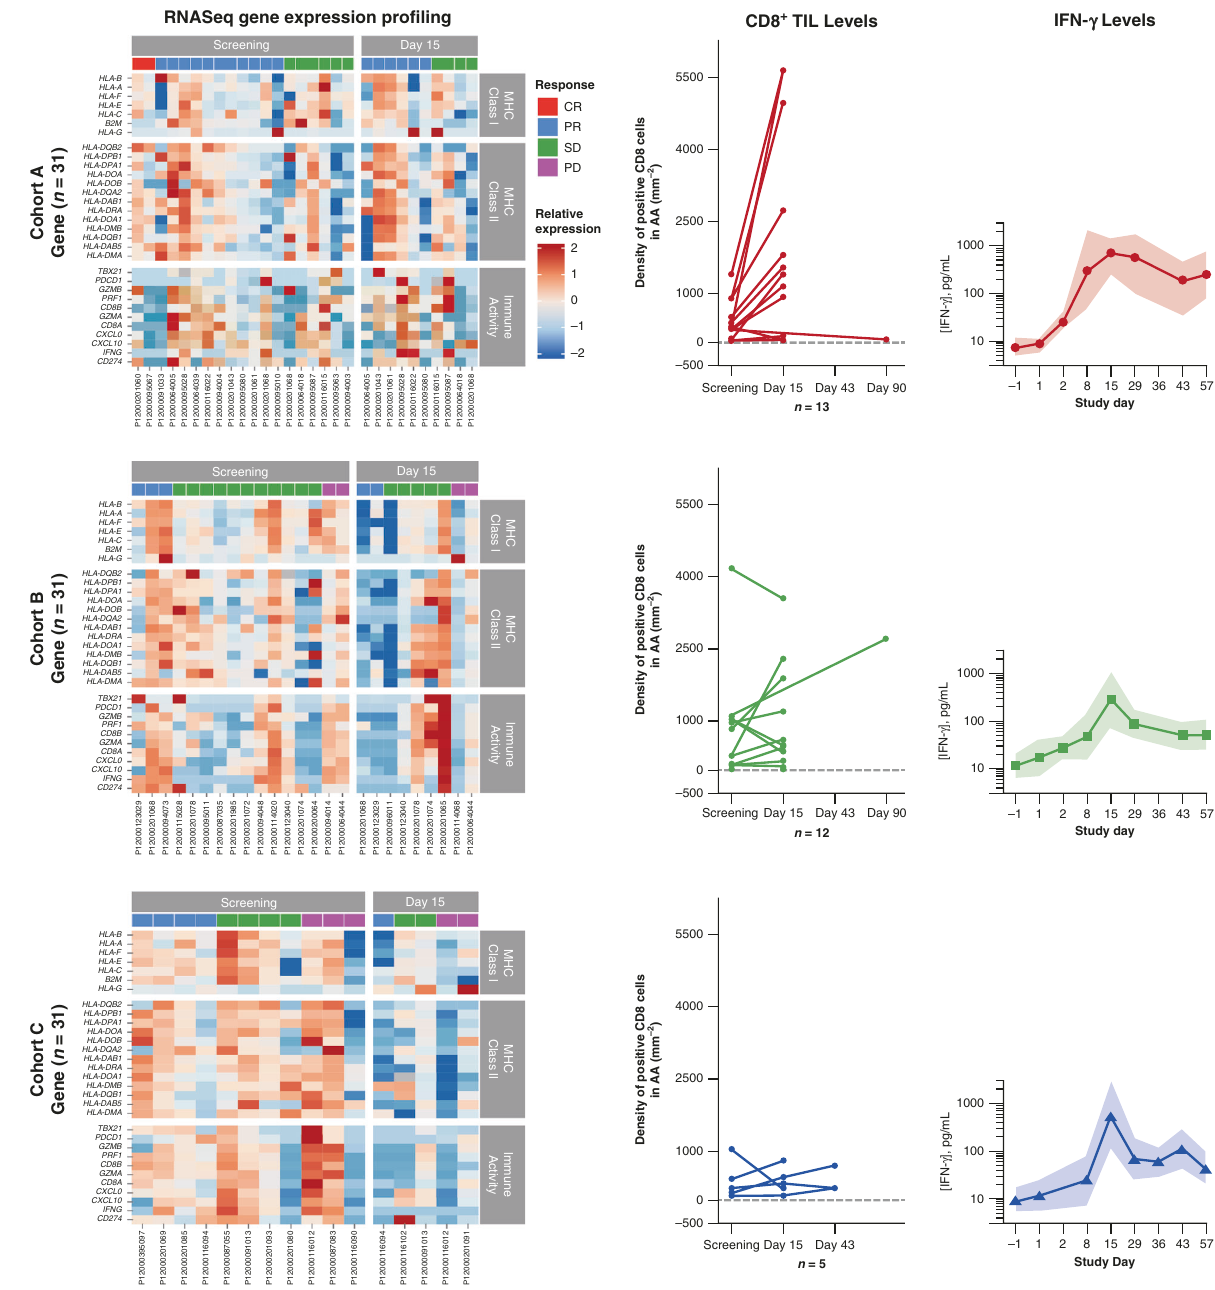
Fig. 3 RNA-sequenced gene expression pro fi ling, CD8 + T-cell in fi ltration by IHC, and IFN γ levels in circulating blood. Cohort A, n = 13; Cohort B, n = 12; Cohort C, n = 5. CR complete response, IHC immunohistochemistry, IFN- γ interferon-gamma, PR partial response, PD progressive disease, SD stable disease, TIL tumor-in fi ltrating